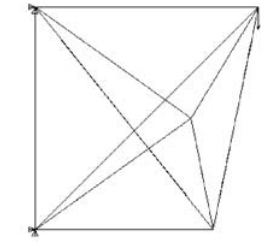
Fig. 5. 7-node truss system and the best solution The largest truss topology optimization problem